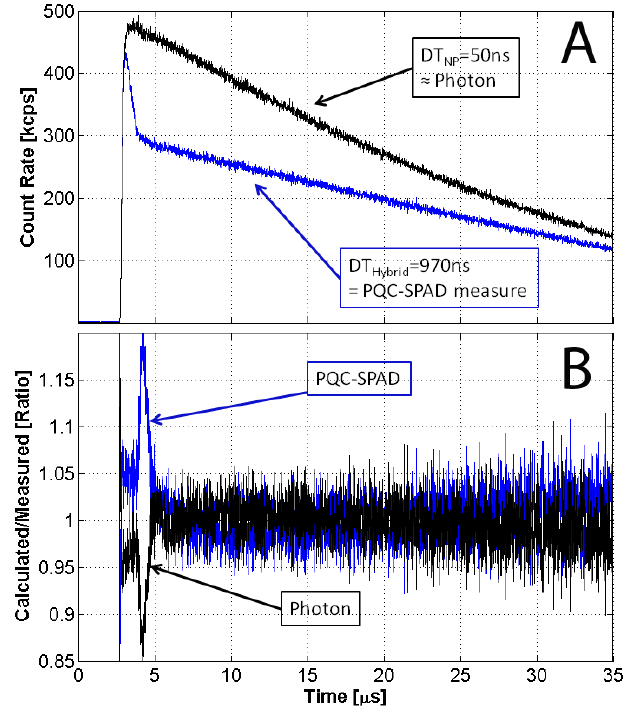
Figure 3. (A) black, true count rate, measured with active quenched SPAD; blue, measured count rate that suffer Hybrid DT losses (passive quenched SPAD). (B)